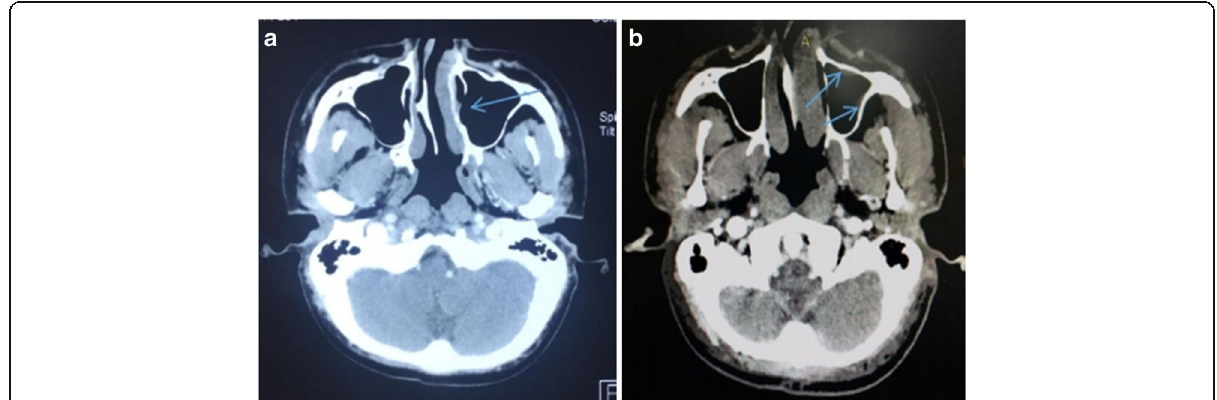
Fig. 3 Repeated CECT scan post-chemotherapy showed multiple nodular opacification (arrow) at medial wall ( a ) and anterior and lateral wall ( b ) of left maxillary